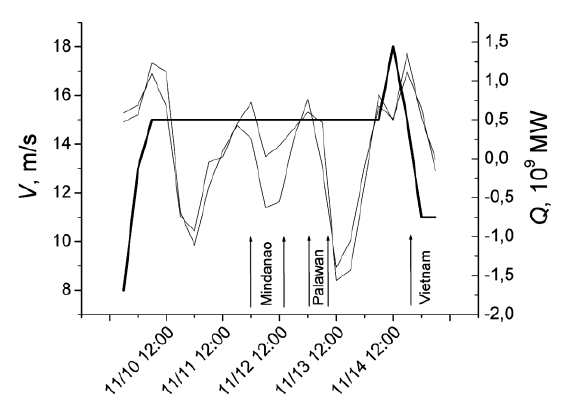
Figure 11. The TS Podul